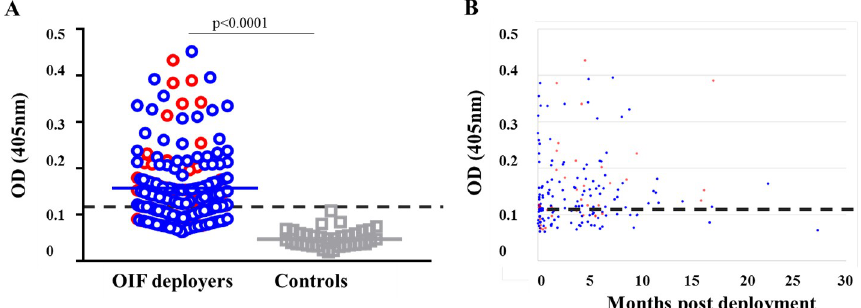
Fig 1. The humoral response to SGH of Phlebotomus alexandri (A) ELISA reactivity of banked sera from OIF deployers (n = 200) and never traveled controls (n = 46) against SGH. (B) Anti-SGH total IgG levels of OIF deployers measured at a median of 4 (range 1–22) months post-deployment (once per subject). Dotted black line shows the cutoff value, which is defined as the mean OD + 3 SDs for the values obtained with sera from never-traveled controls (0.108). AVL subjects are represented in red dots, blue dots are subjects who deployed but were not infected (AVL - ) and grey squares are never traveled controls. The significance of differences between groups was evaluated by the Mann-Whitney test. P values of < 0.05 were considered significant. Solid lines indicate mean OD